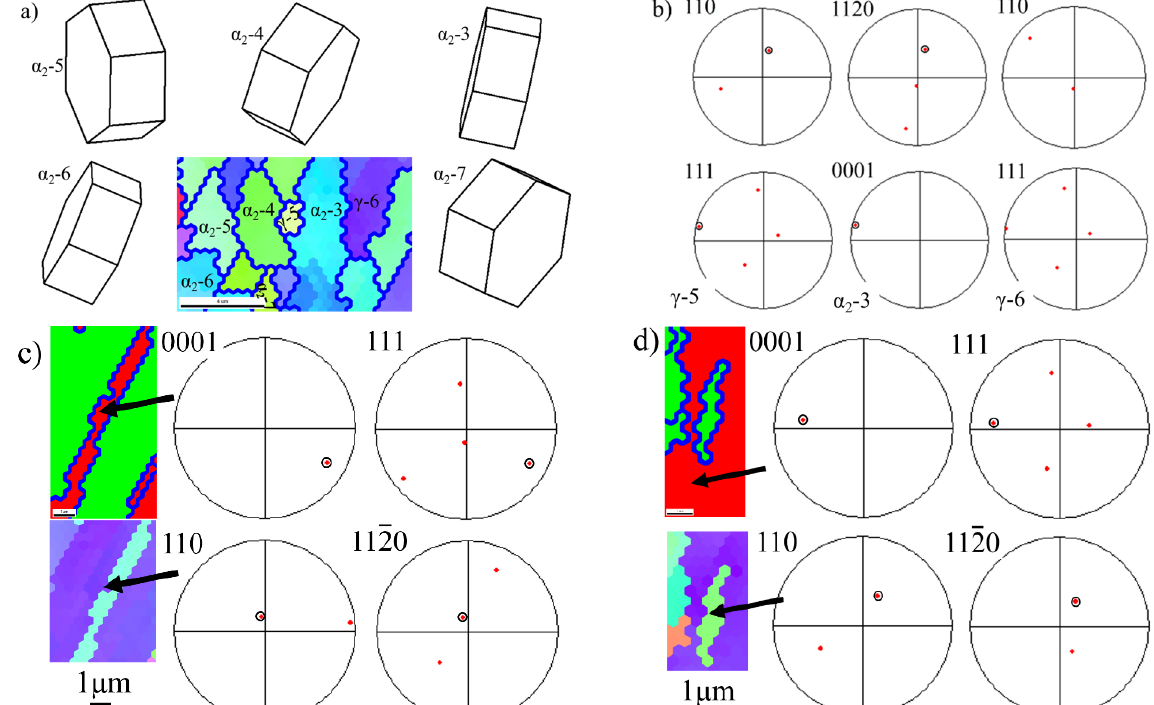
Figure 6. Local orientation maps and pole figures of the corresponding α 2 and γ grains in the black rectangle in Figure 4b: magnification of ( a ), ( b ) region 1, ( c ) region 2, and ( d ) region 3.